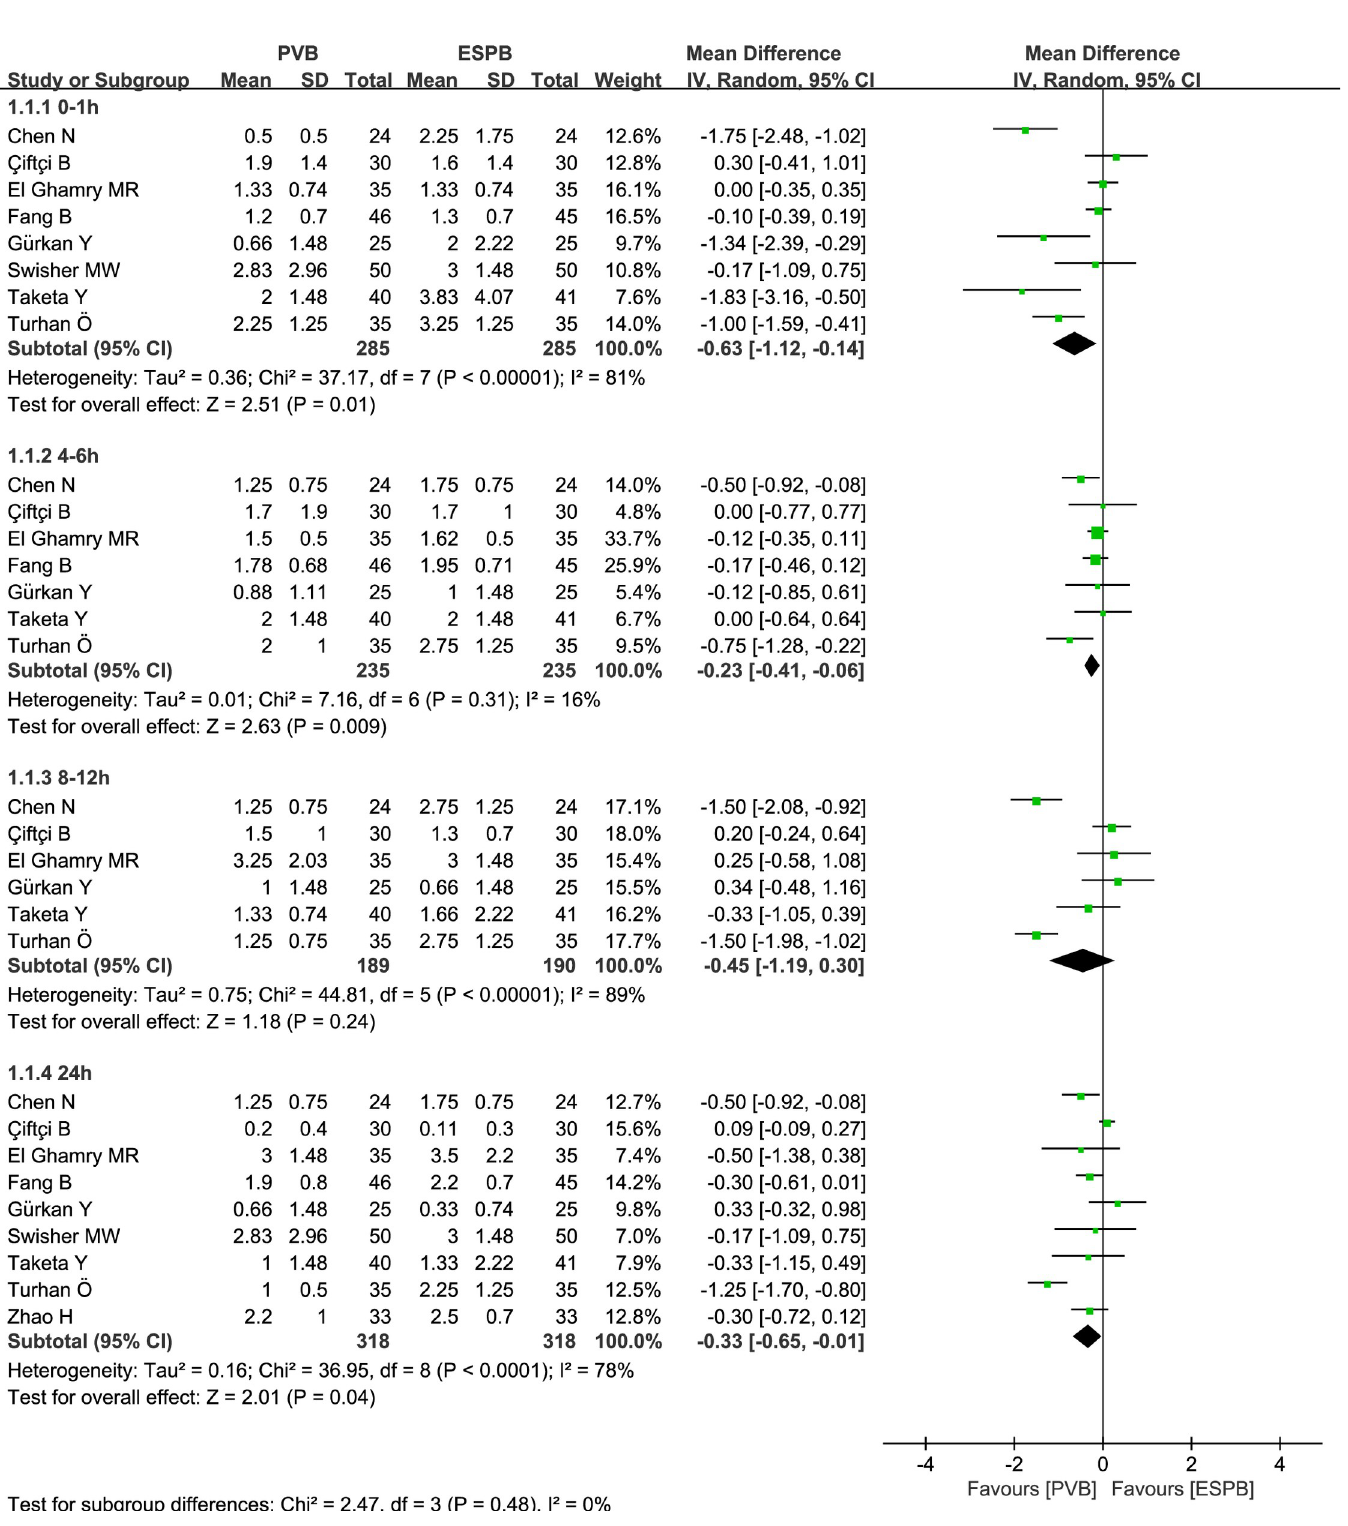
PLOS ONE | https://doi.org/10.1371/journal.pone.0256611 August 25,